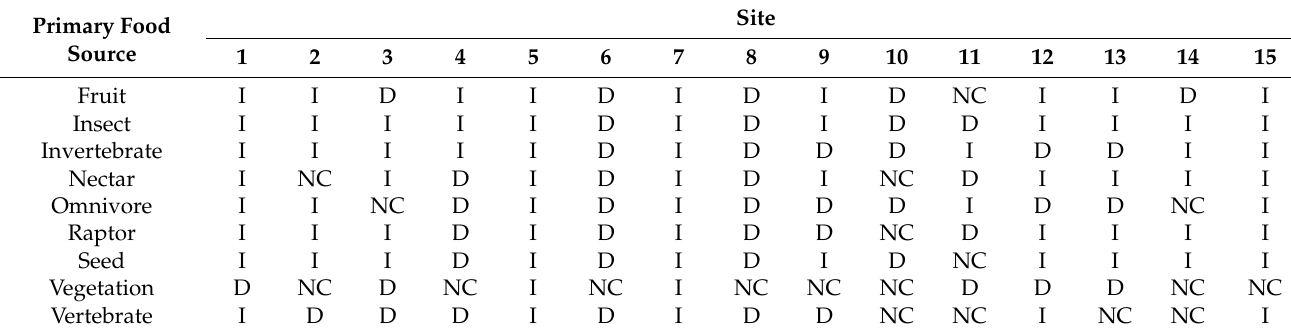
Subsequent analysis found that there was no significant change in species numbers by primary food source overall (Table 4). Table 4. Change in species numbers across sites where greenspace has decreased; I = increase, D = decrease and NC = no change.